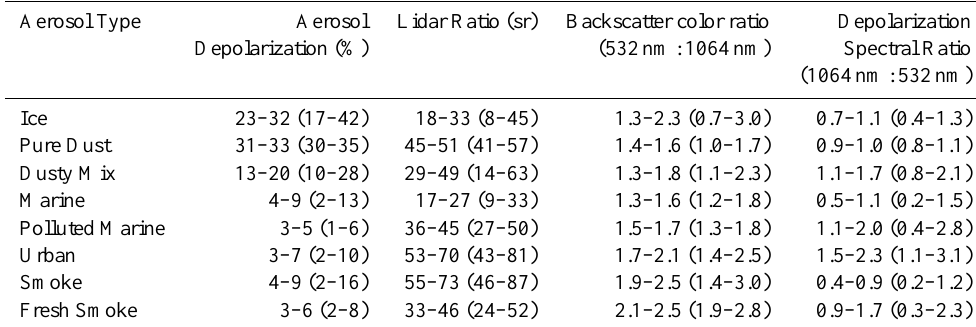
Table 1. Ranges of the measured aerosol intensive parameters are given for all HSRL-1 classified measurements from 2006–2012. Ranges are given as first and last quartile, with 5th and 95th percentiles in parenthesis.